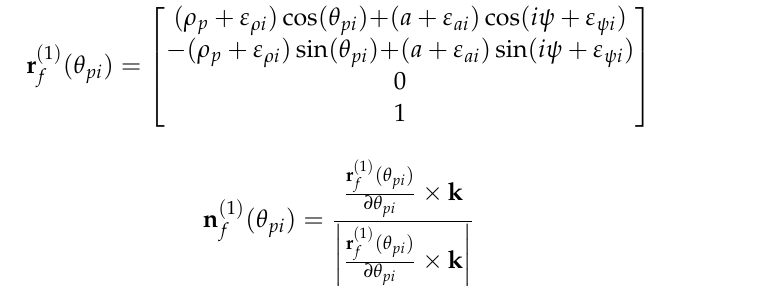
Figure 5. Coordinate systems for the unloaded TCA.